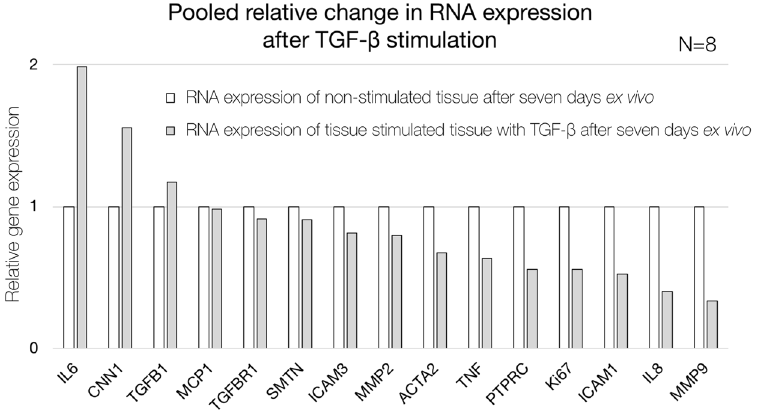
Figure 8. Quantification of gene expression of pooled non-stimulated (white) and TGF- β -stimulated (grey) AAA patient tissue sections after seven days ex vivo . Relative expression is shown as ratio based on non- stimulated tissue sections. IL6 indicates interleukin 6; CNN1 , calponin 1; TGFB1 , transforming growth factor beta 1; MCP1 , monocyte chemotactic protein 1; TFBR1 , transforming growth factor beta receptor 1; SMTN , smoothelin; ICAM3 , intercellular adhesion molecule 3; MMP 2, matrix metalloproteinase-2; ACTA2 , alpha smooth muscle actin 2; TNF , tumor necrosis factor; PTPRC , protein tyrosine phosphatase, receptor type, C; Ki67 , antigen KI-67; ICAM1 , intercellular adhesion molecule 1; IL8 (or CXCL8) , interleukin 8 and MMP9 , matrix